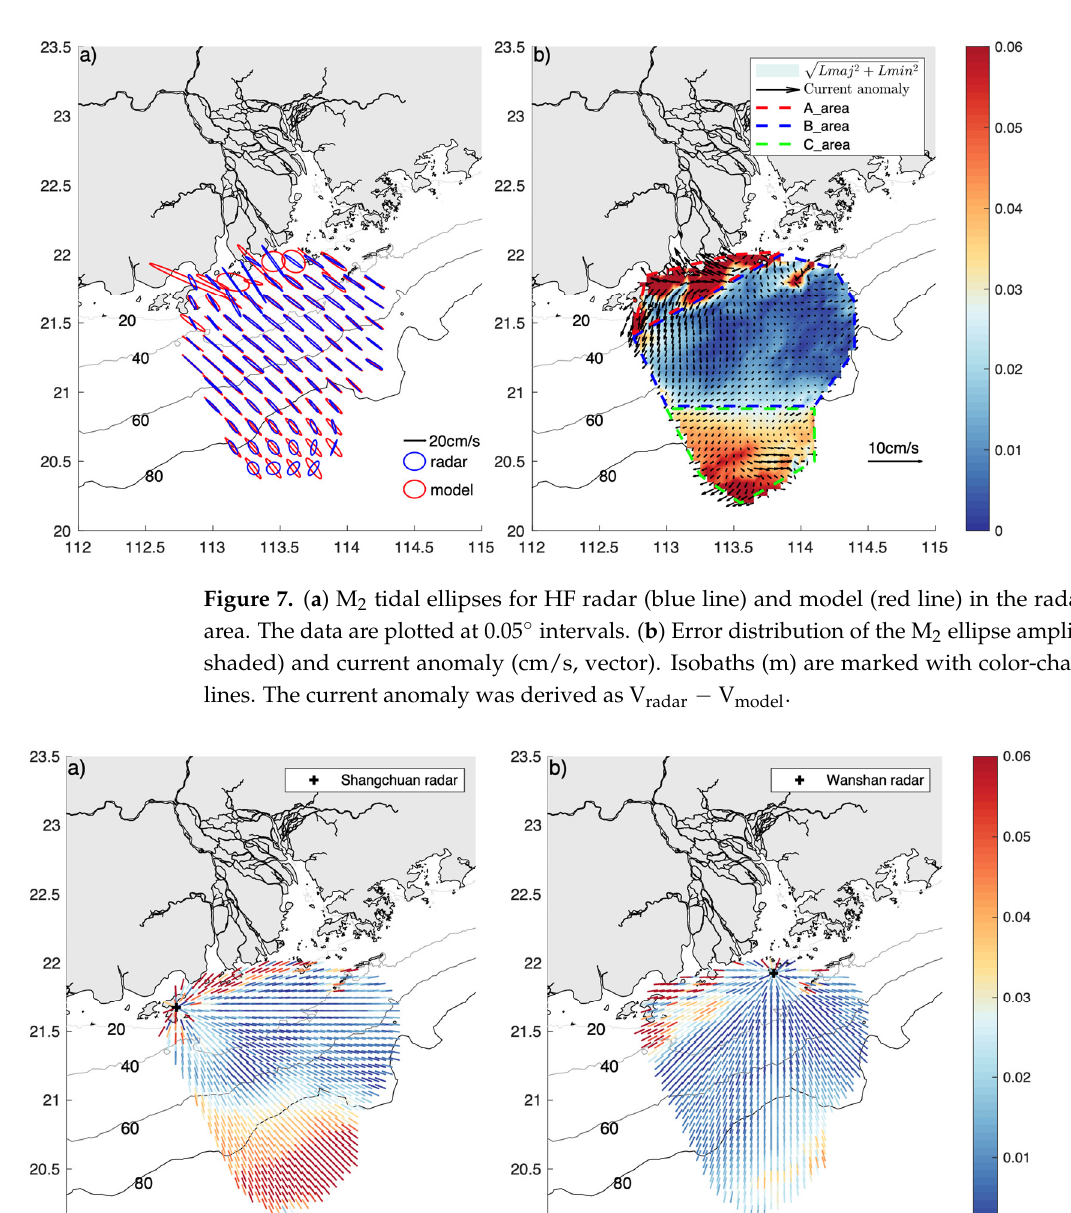
Figure 9. Comparison between model and radar radial components of the tidal ellipse at ( a ) Shang- chuan and ( b ) Wanshan stations. Points in area A, red circles; points in area B, blue circles; points in area C, green circles.